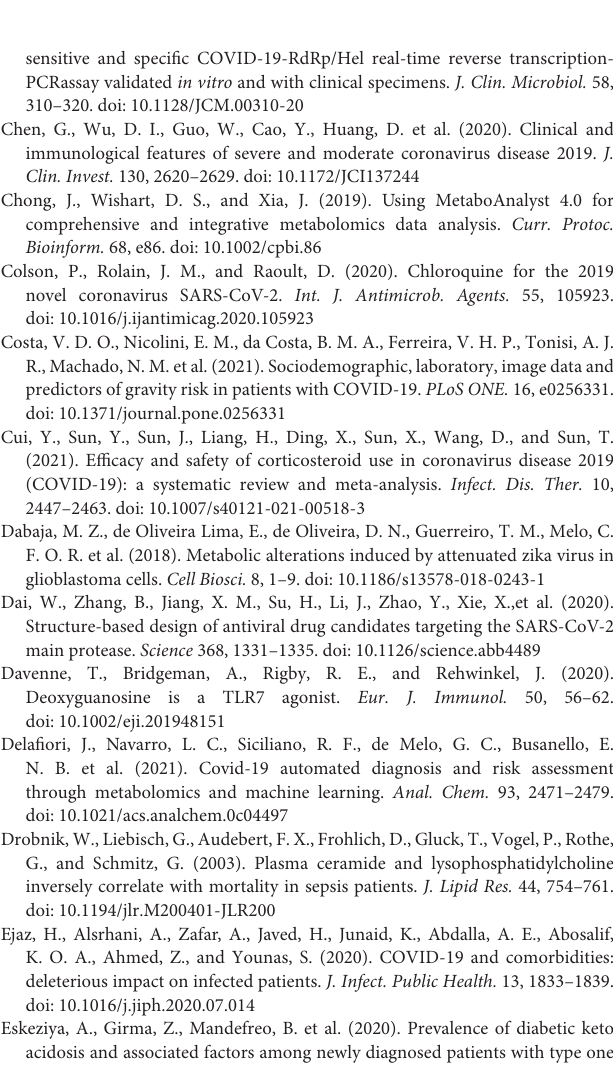
Supplementary Figure 1 | Volcano plot displaying p -value vs . log 2 FC for selecting and ranking m/z features for metabolite identification. Supplementary Figure 2 | Metabolites ranked based on the variable importance in projection (VIP) score. Supplementary Figure 3 | Permutation test statistics for the PLS-DA score plot. (A) Prediction accuracy during training; (B) Separation distance. Supplementary Table 1 | Characteristics of biomarkers uniquely identified from plasma samples of COVID-19 patients categorized as having severe or non-severe disease